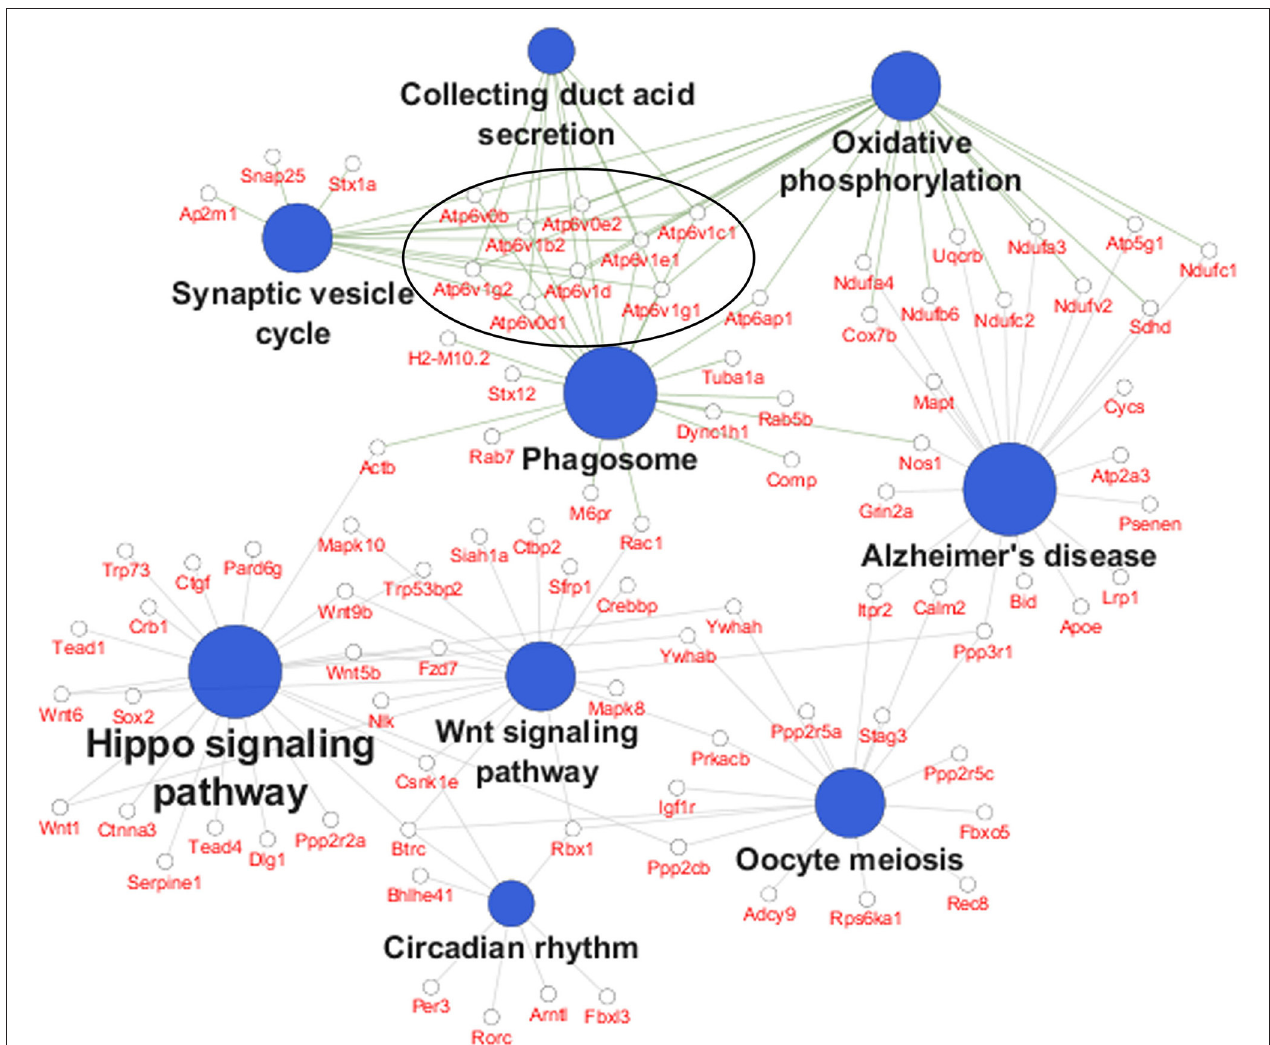
FIGURE 2 | Pathway analysis reveals numerous pathways affected by differential APOE isoform expression . A pathway analysis was performed on the differentially expressed EC genes using Cytoscape’s ClueGo application. Shown here are the significantly enriched KEGG pathways observed in the EC of APOE3/4 vs. APOE3/3 mice, with the 9 differentially expressed V-type ATPase genes circled. (Further details can be found in Table 1